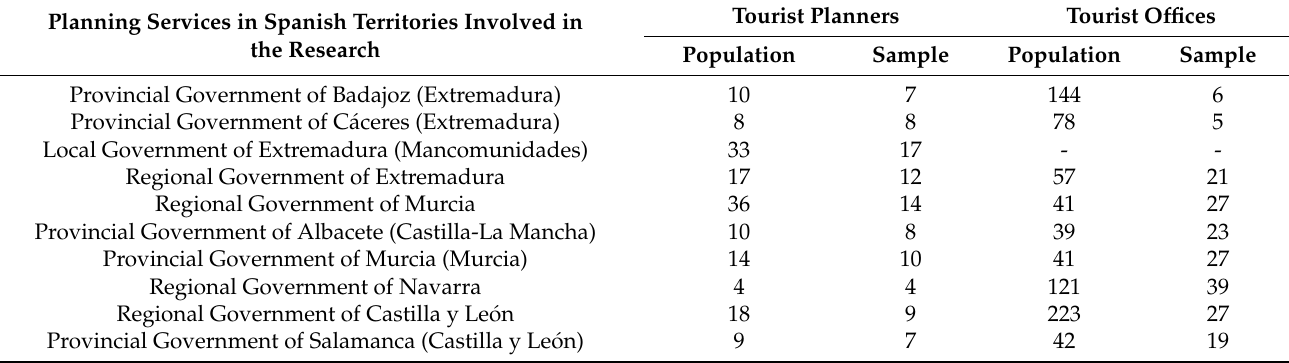
Table 1. Tourist planners and tourist offices in